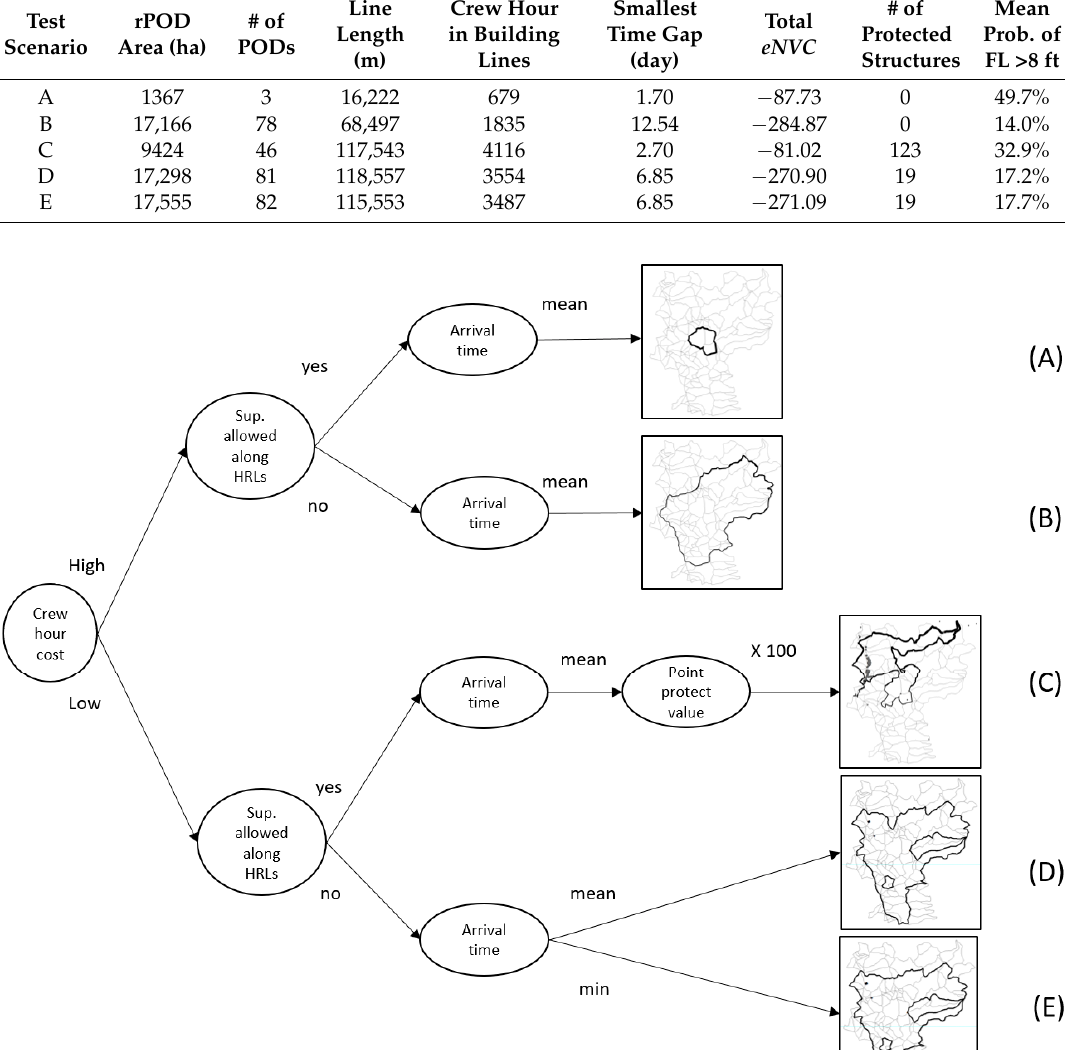
Table 4. Solution characteristics for the tested scenarios A through E in the decision tree (Figure 6).